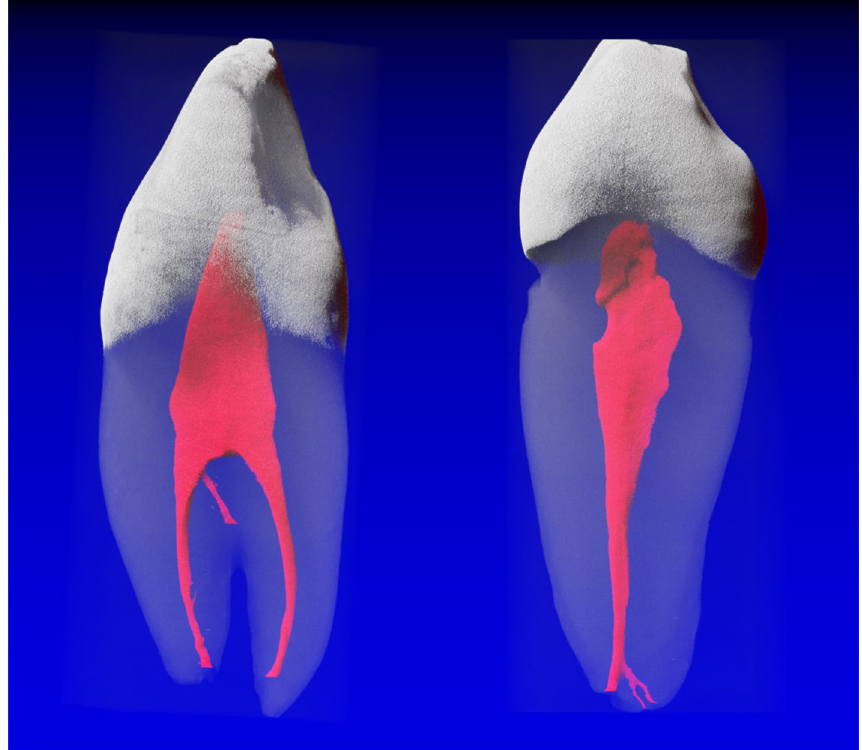
Figure 2. Mandibular canine with a 1-2-2/2 (left) root canal configuration (RCC) and one accessory (interradicular) canal in the middle third. A 1-1-1/1 RCC (right) with one accessory canal which divides into two accessory canals/foramina can be observed.